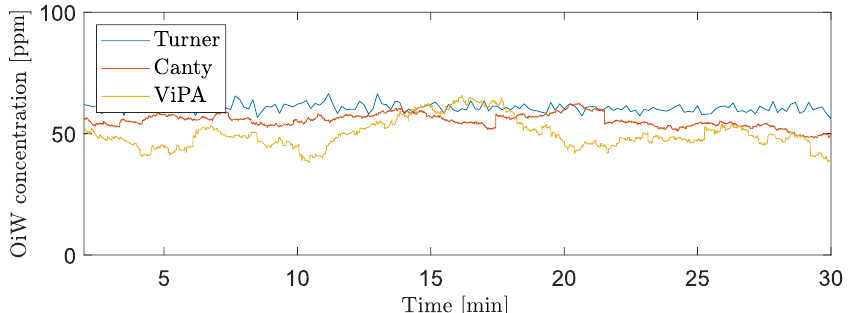
Figure 21. Real-time OiW concentration measurements calculated extending the trailing moving average window to 3 min for both C 2 and C 3